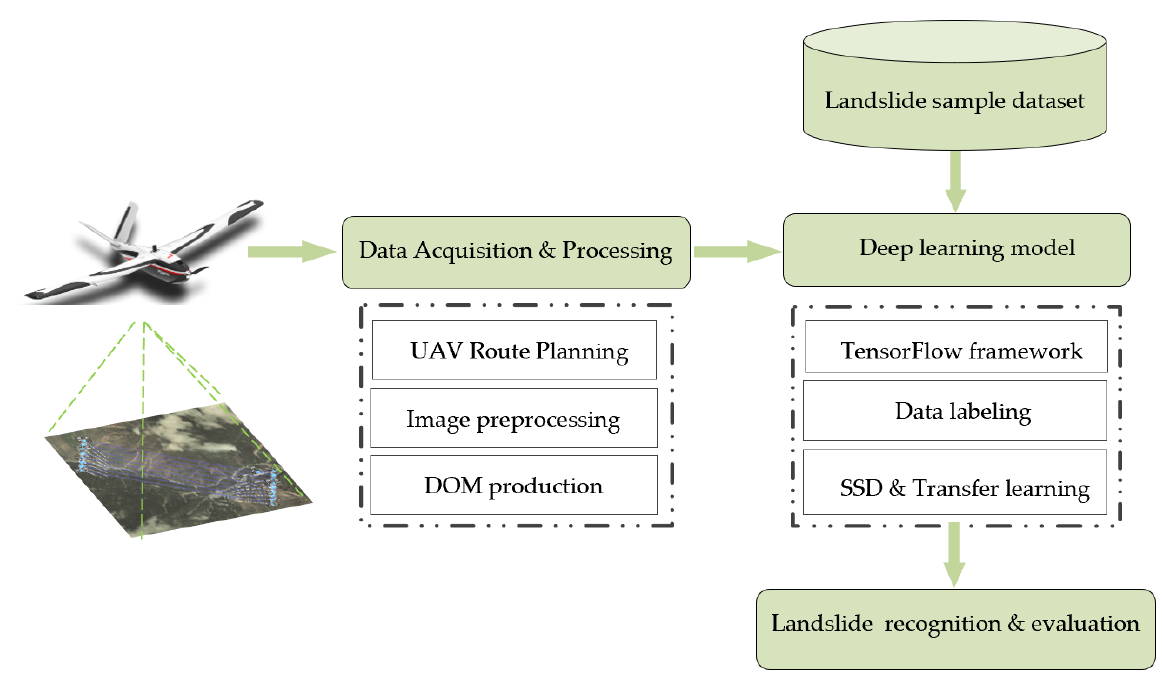
Figure 4. Research framework.